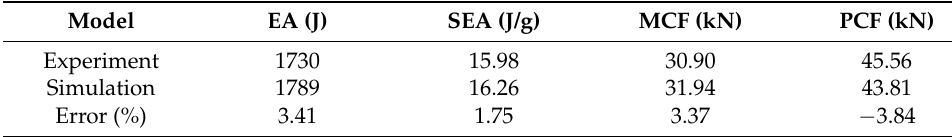
Table 10. Energy absorption properties for FLNT-4.